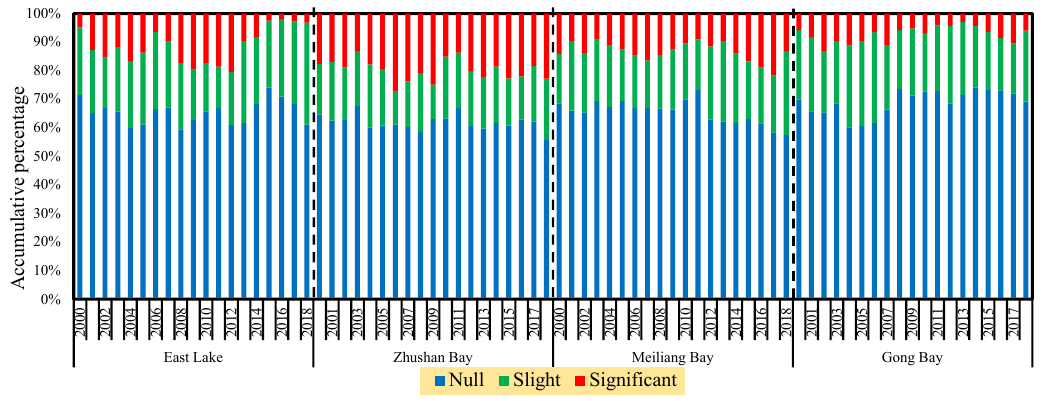
Figure 15. Accumulative percentage of cyanobacteria bloom severity level for the entire lake (excluding East Bay) and each segment. Significant, slight, and null cyanobacteria blooms are defined as FAI > −0.004 coverage area (FA d ) larger than 25%, larger than 5% but less than or equal to 25%, and less than or equal to 5% of entire lake or each segment, respectively.